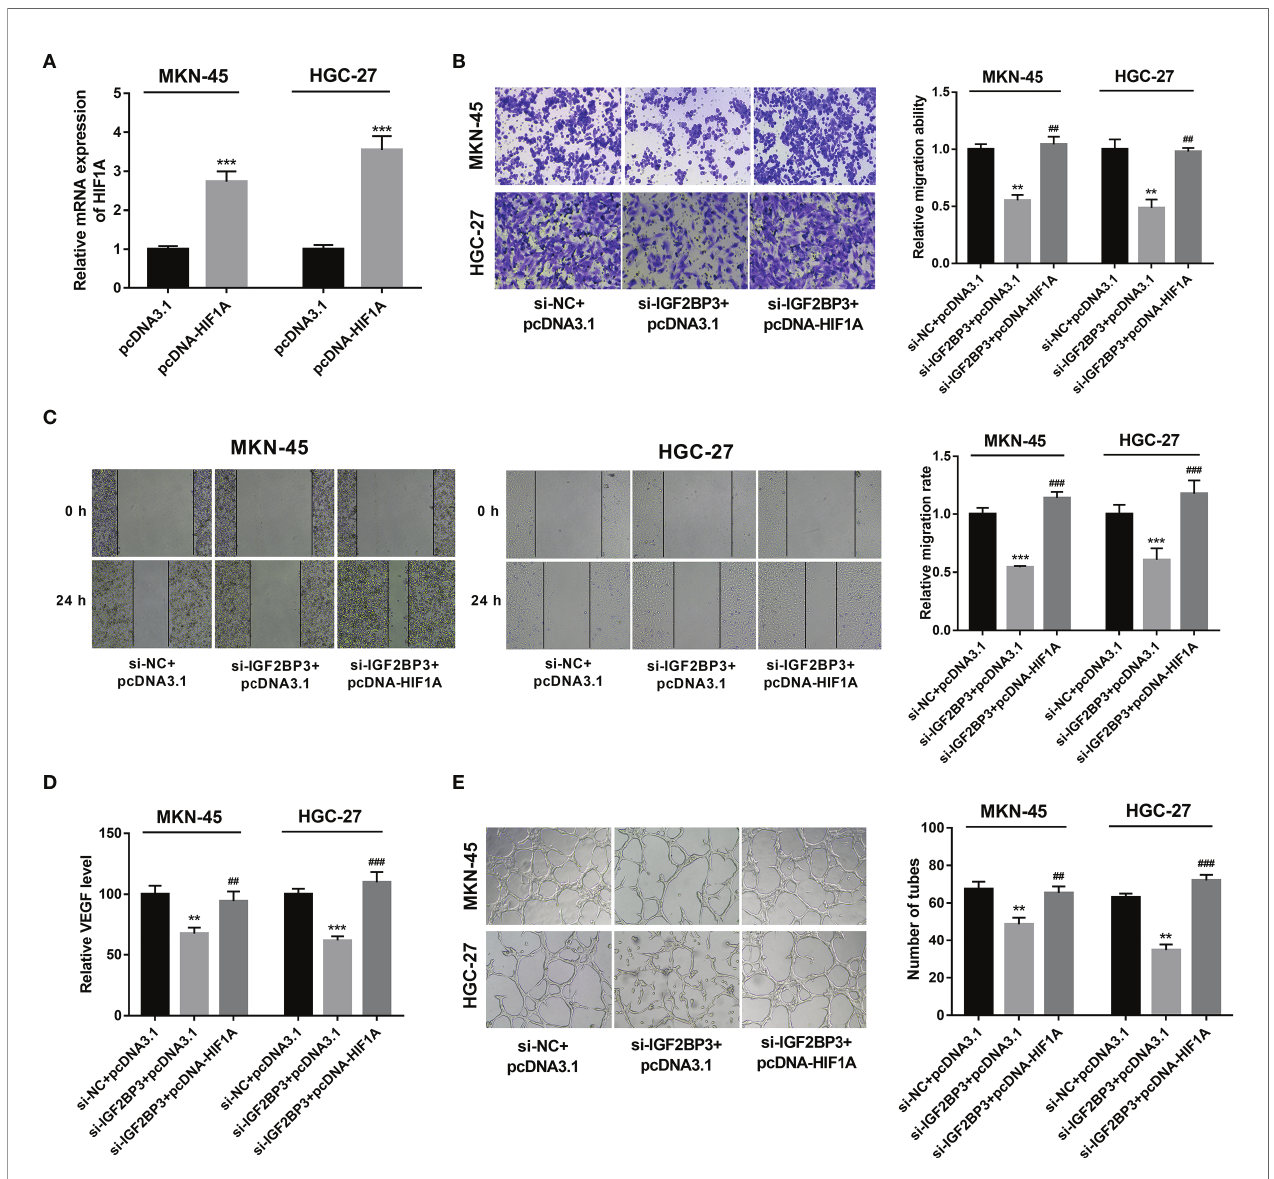
FIGURE 5 | IGF2BP3 exerted its functions by up-regulating HIF1A. (A) MKN-45 and HGC-27 cells were transfected with pcDNA3.1 or pcDNA-HIF1A. Next, HIF1A mRNA level was measured by RT-qPCR assay at 48 h upon transfection. (B – E) MKN-45 and HGC-27 cells were transfected with si-NC+pcDNA3.1, si-IGF2BP3#1+pcDNA3.1, or si-IGF2BP3#1+pcDNA-HIF1A for 48 h and then maintained in hypoxic conditions for another 24 h, followed by the examination of cell migratory potential (B, C) and VEGF secretion level (D) . (E) MKN-45 and HGC-27 cells were transfected with si-NC+pcDNA3.1, si-IGF2BP3#1+pcDNA3.1, or si-IGF2BP3#1+pcDNA-HIF1A for 48 h and then maintained in hypoxic conditions for another 24 h, followed by the collection of conditioned medium. Next, HUVECs were cultured in a mixed medium of ECM and conditioned medium (volume ratio=1:1) and tube formation potential was examined at 12 h after incubation. ** p < 0.01, *** p < 0.001, ## p < 0.01, ### p <